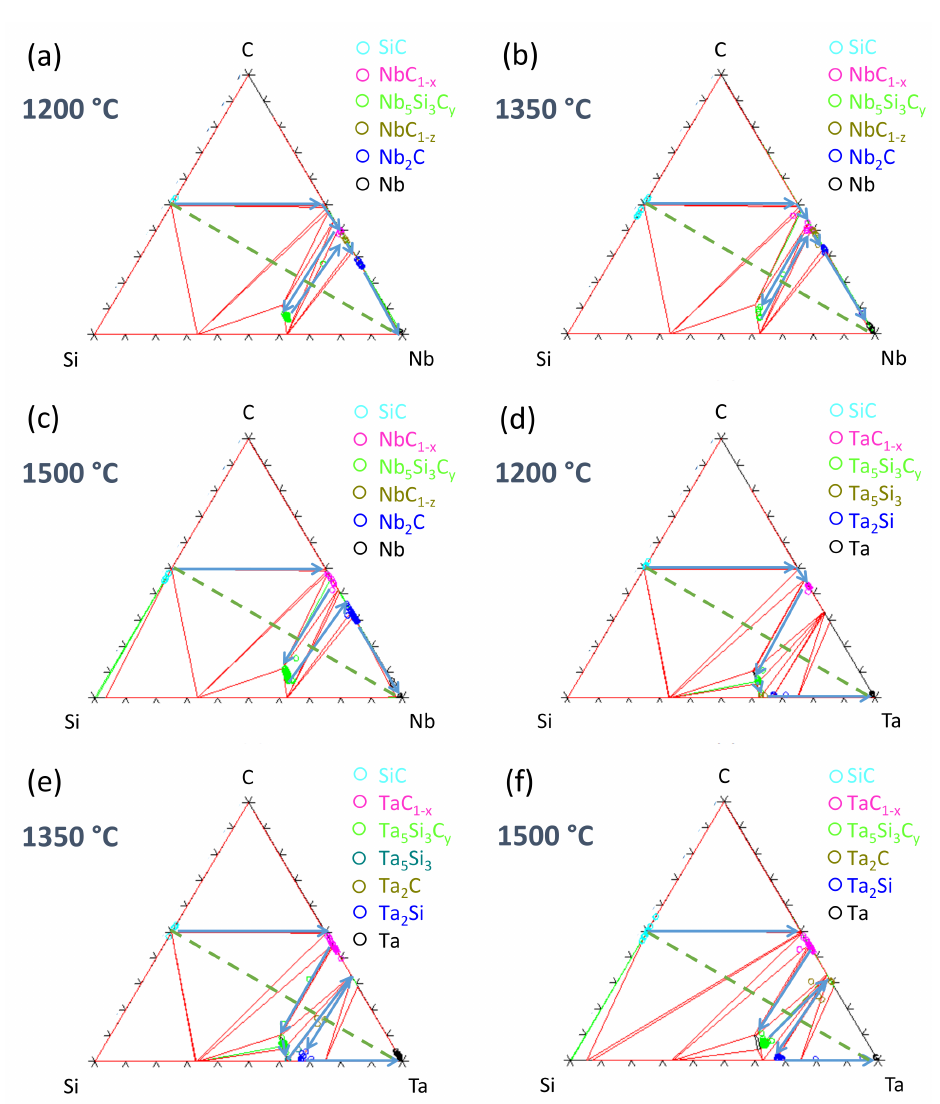
Figure 19. Diffusion paths determined from EPMA measurements in the Nb/SiC (( a – c ) and Ta/SiC ( d – f )) systems at 1200 ◦ C, 1350 ◦ C and 1500 ◦ C,